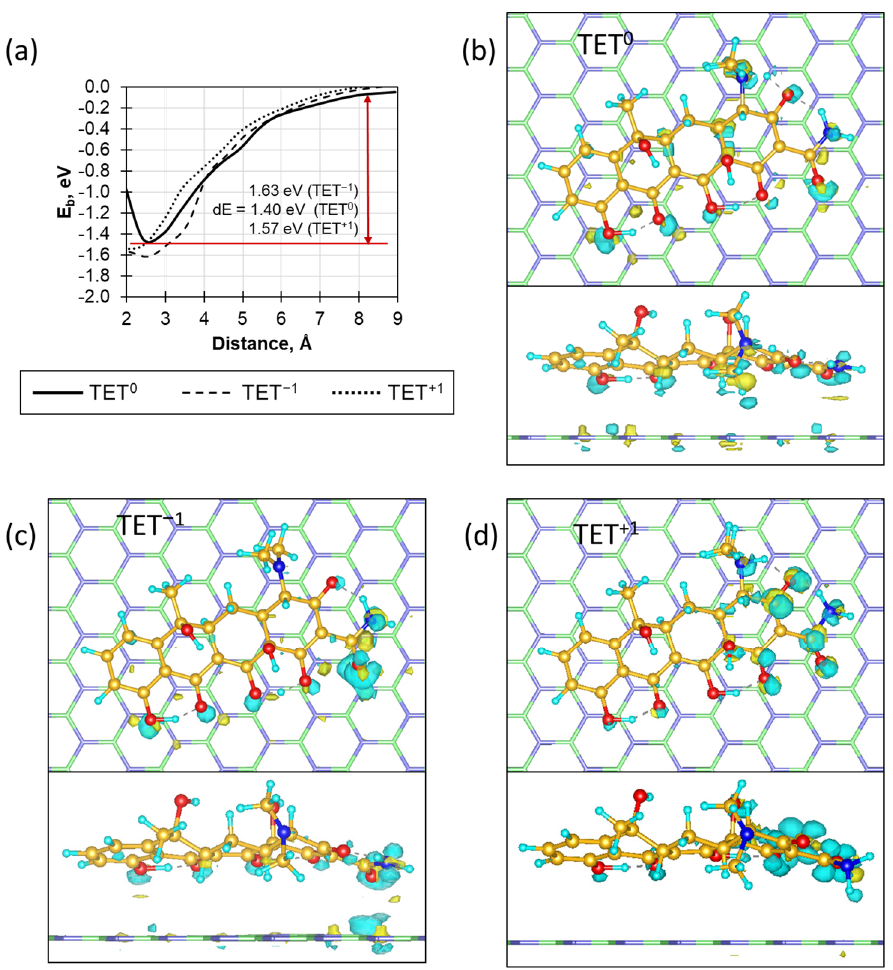
Figure 6. ( a ) The changes in binding energy as a function of the distance between tetracycline and the boron nitride surface for uncharged (solid line), negatively (dashed line) and positively (dotted line) charged forms of TET. The electron density redistribution at the BN/TET interface for ( b ) uncharged, ( c ) negatively and ( d ) positively charged forms of TET. The loss and gain of charge are denoted by yellowish and bluish colors, respectively. The boron, nitrogen, carbon, oxygen, and hydrogen atoms are marked by green, blue, yellow, red, and cyan colors, respectively. The isosurface constant value is 0.01 eV/Å.